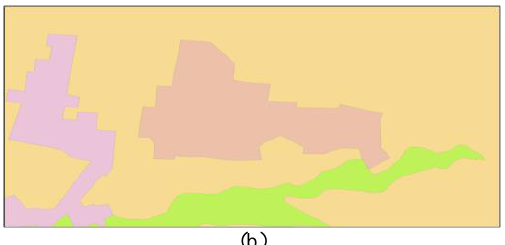
Figure 1. Merger of land-cover data based on the global optimum. (a) Original land-cover areas; (b) aggregation results.